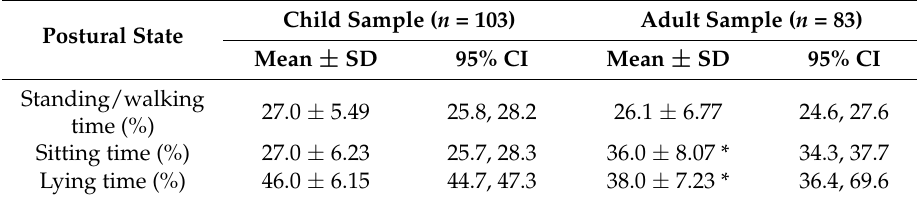
Table 2. Basic physical activity metrics obtained from paired Axivity AX3 accelerometers in children and